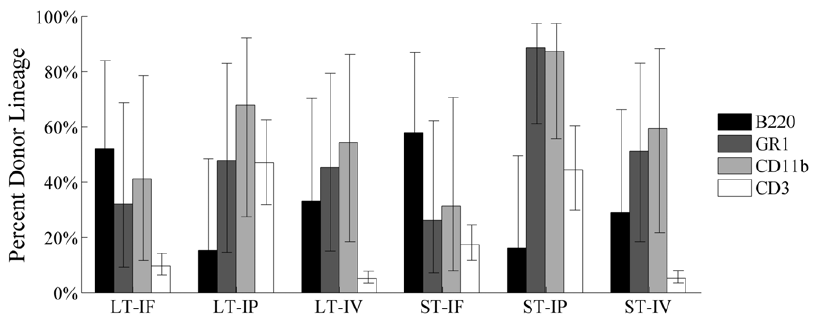
Figure 8. Multilineage nature of engraftment: Summary graph of all primary transplant experiments showing that when engraftment occurred, multiple cell types were seen. Therefore, points displayed represent percent of cells from donor. Serial transplants of the primary whole bone marrow were also multilineage in nature when engraftment occurred (data not shown).